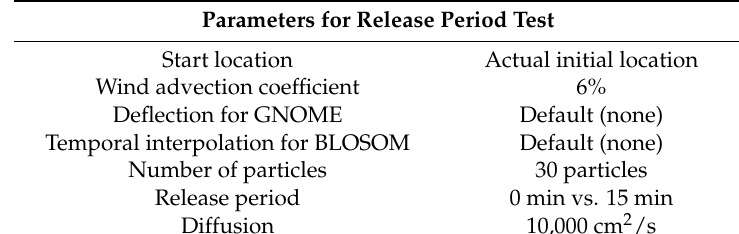
Table 11. Parameters for release period test.